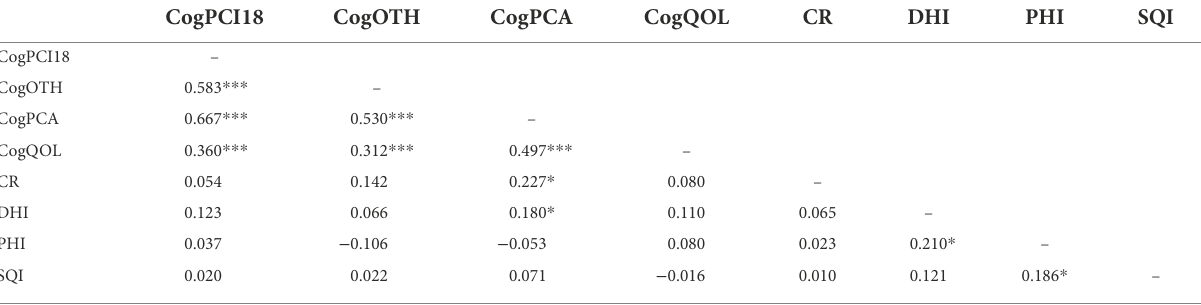
TABLE 4 Correlation table of cognitive and behavioral, psychosocial, and lifestyle variables in age-matched controls.